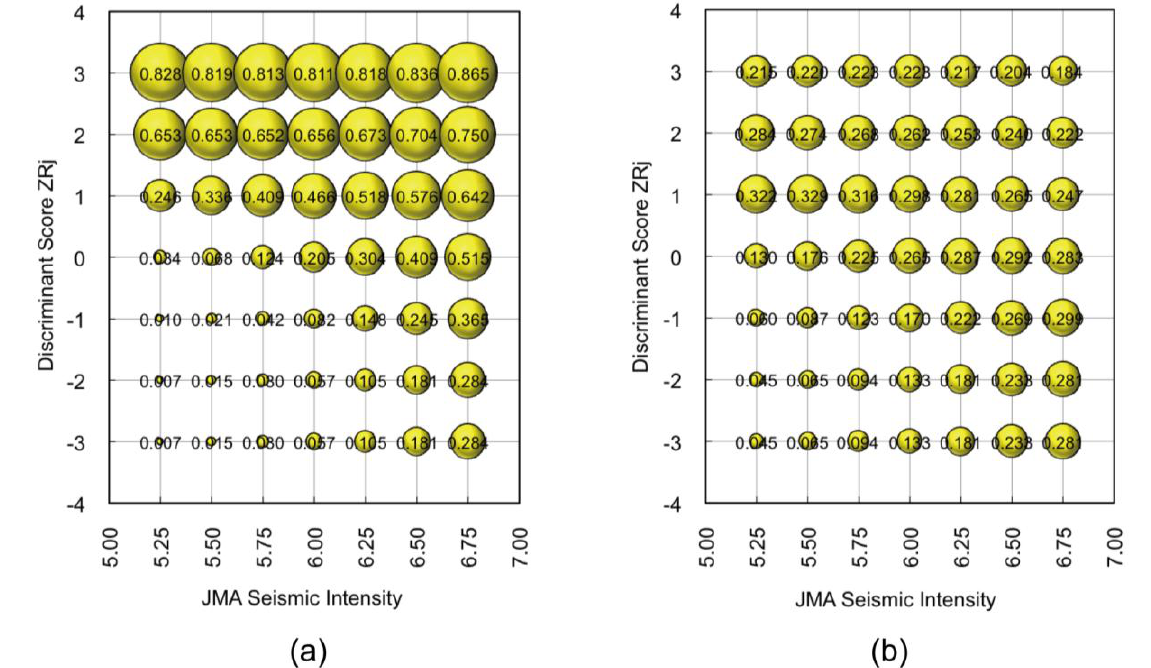
Figure 9. Estimated severe damage ratio from integration of SAR information and seismic intensity information. (a) Average values. (b) Standard